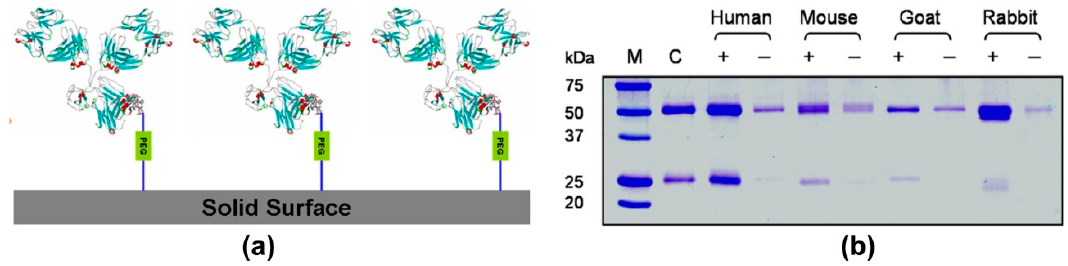
Figure 5. ( a ) Illustration of antibody binding on a solid surface using Fc-binding peptide Fc-III; ( b ) SDS-PAGE analysis of IgGs bound to Fc-III covered magnetic beads. Human IgG1 ( K d = 85 ± 5 nM), mouse IgG3 ( K d > 20 μ M), goat IgG3 ( K d not given), and rabbit IgG ( K d = 305 ± 37 nM) were incubated with Fc-III functionalized (+) or unmodified ( − ) magnetic beads. After washing steps with PBS, the bound IgG were applied to a 10% SDS-polyacrylamide gel. Protein size marker (M) and 1 μ g of human IgG (C) are indicated. Adapted from [70] with permission from © 2016 Elsevier.